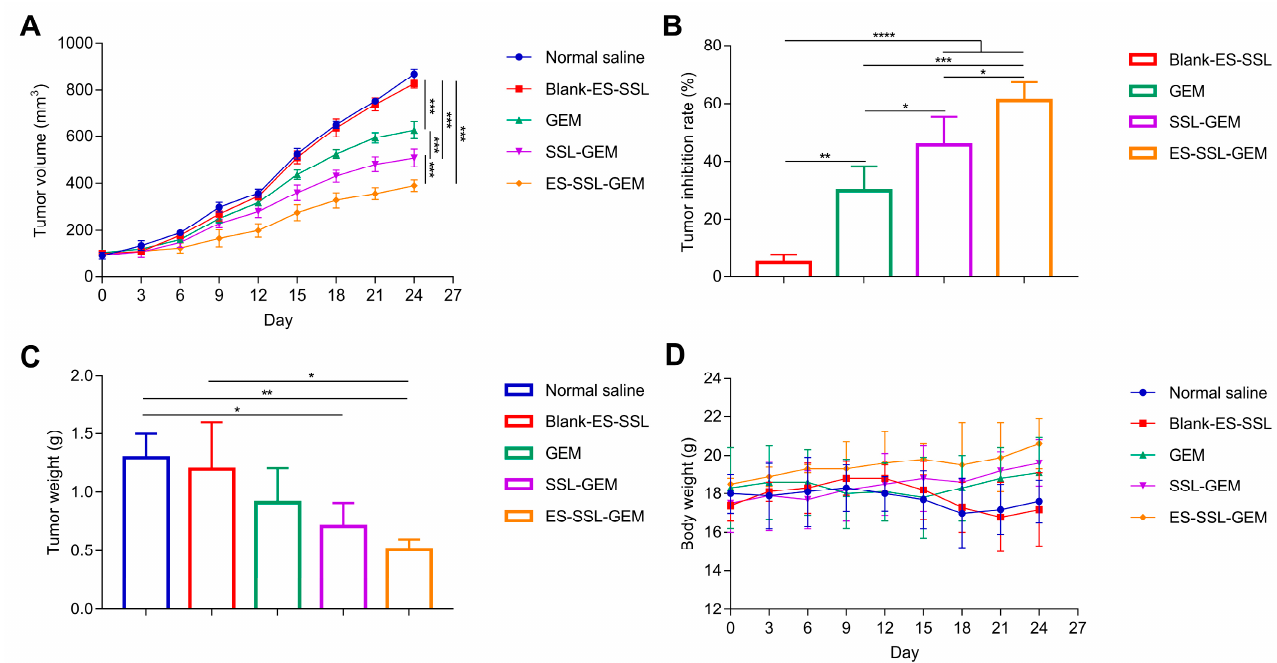
Figure 9. In vivo antitumor effect of ES-SSL-GEM (n = 4). ( A ) Tumor growth curves of BALB/c nude mice after GEM formulations treatment. ( B ) Tumor inhibition rate and ( C ) the weight of the tumor after the experiment. ( D ) The body weight change curves after injection of different formulations. * p < 0.05, ** p < 0.01, *** p < 0.001, **** p < 0.0001.